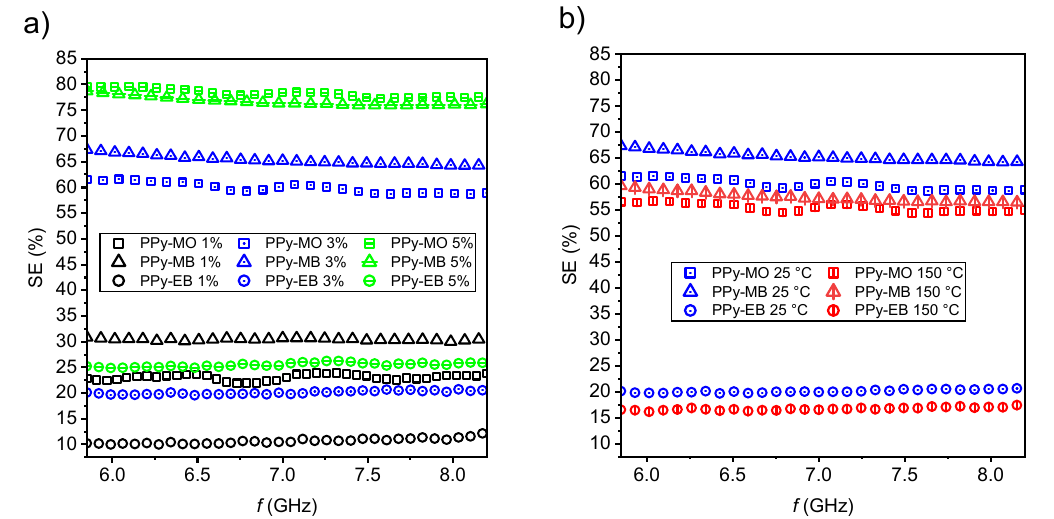
Figure 3. EMI shielding efficiency of PPy 1D nanostructures in the range from 5.85 to 8.2 GHz ( a ) for various loadings 1, 3 and 5% w / w (curing temperature 25 ◦ C), ( b ) for curing temperatures 25 and 150 ◦ C (loadings 3% w / w ).